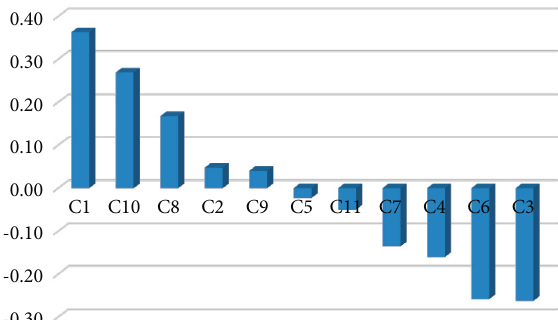
Figure 4: Difference between impact and effectiveness of